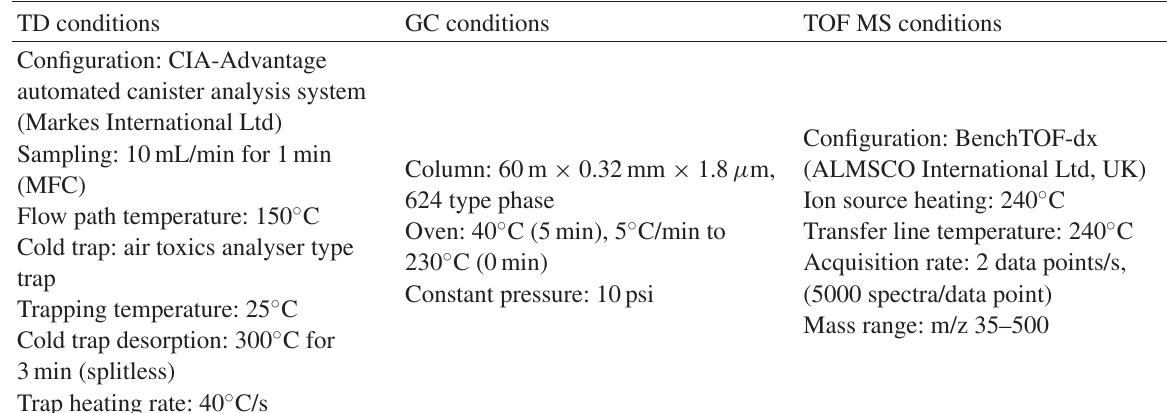
FIGURE 7: Total ion chromatogram showing splitless analysis of only 10 mL of semi-rural air using TD- GC/TOF MS (TD; CIA -Advantage system, Markes International Ltd, TOF MS; BenchTOF-dx ALMSCO International Ltd, UK). Inset: extracted-ion chromatogram for a characteristic fragment ion of Freon 113 (present in the atmosphere at ca. 80 ppt). Method conditions are shown in Table 5. TABLE 5: Analytical